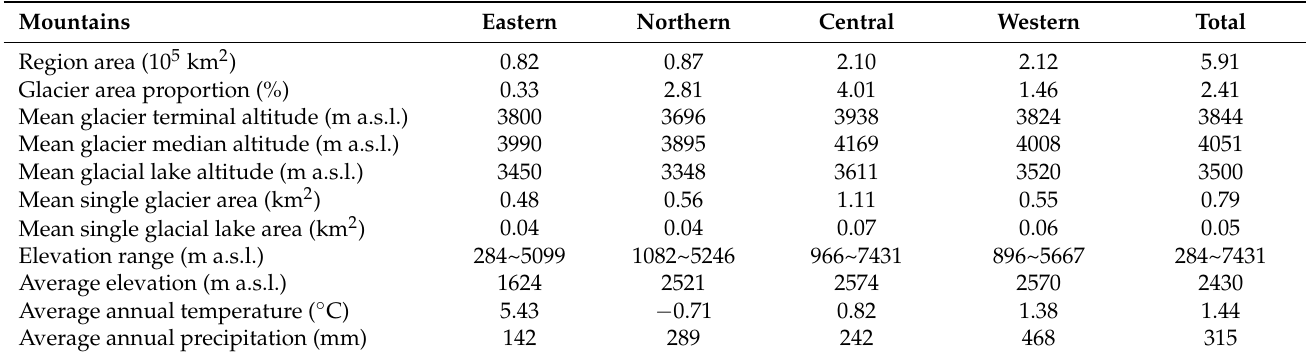
Table 1. The geographic characteristics of the TS, Central